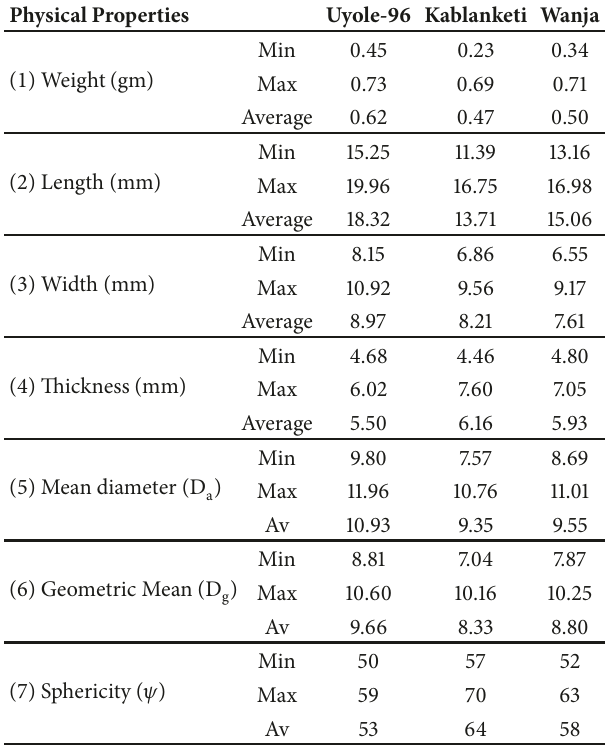
Table 2: Common beans physical properties measurements. Physical Properties